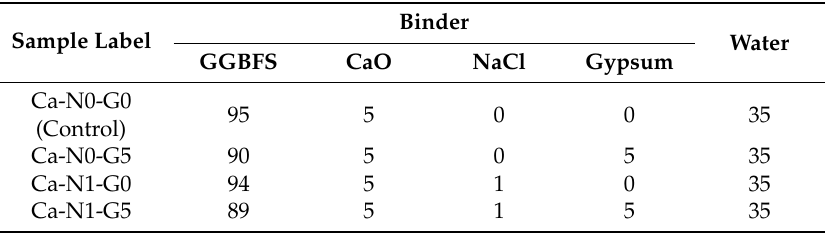
Table 2. Mixture proportions of paste samples (wt